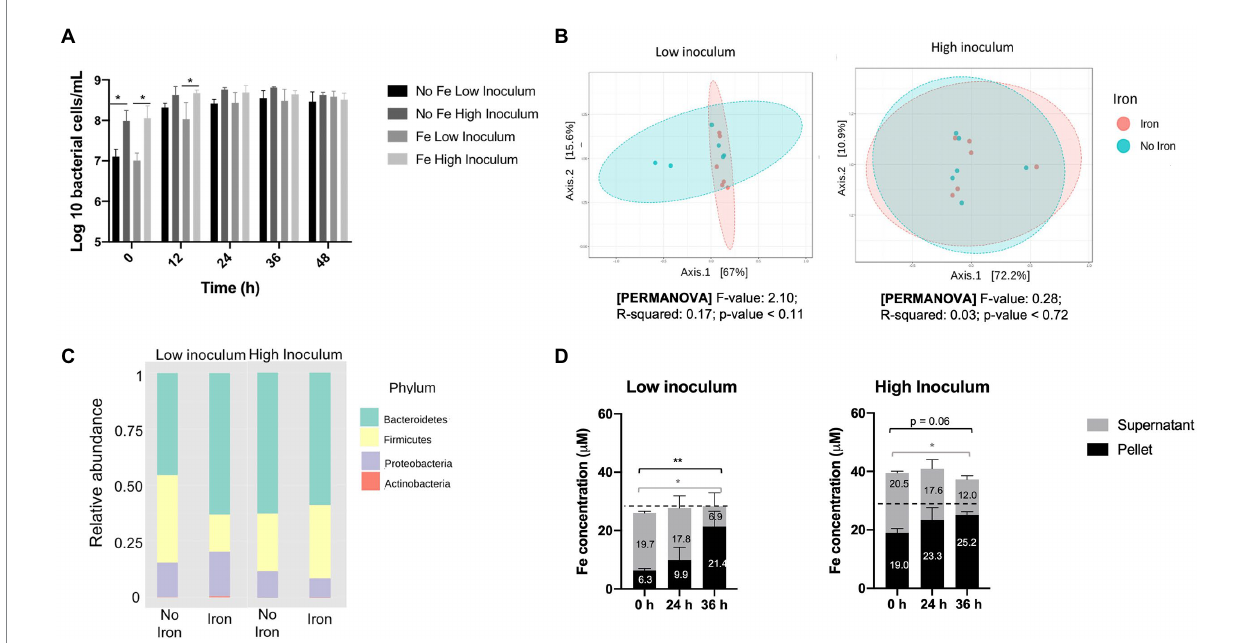
FIGURE 2 Impact of iron supplementation on the human gut microbiota at high and low inoculation levels using standard gut model medium (GMM). Single- stage anaerobic batch culture fermentations were performed under two iron regimes: GMM supplemented with 18 μ M FeSO 4 plus 77 μ M haem; or GMM with no iron supplements. In addition, two different inocula levels were used: low (1% w/v); or high (10% w/v). Incubation was for 48 h and performed in triplicate with technical duplicates for each condition. Where shown, error bars indicate standard error. (A) Total bacterial counts over time, as determined by Flow -FISH. (B) Principal coordinates analysis of Weighted Unifrac distances of microbiota composition profiles (as determined by 16S rRNA gene amplicon sequencing) obtained at 36 h in the presence (pink) or absence (turquoise) of iron supplements. (C) Microbiota composition at phylum level in the absence or presence of iron supplements after 36 h. (D) Iron levels in cell pellet and culture supernatant fractions at 0–36 h. Data are only shown for the non-iron supplemented samples since iron-supplemented samples failed to show redistribution of iron from supernatant to pellet (possibly due to an iron saturation effect; data shown in Supplementary Figure S2). Significant differences between time points are denotated with asterisks: * p < 0.05, ** p < 0.01. Dotted line indicates the 28 μ M background iron in the